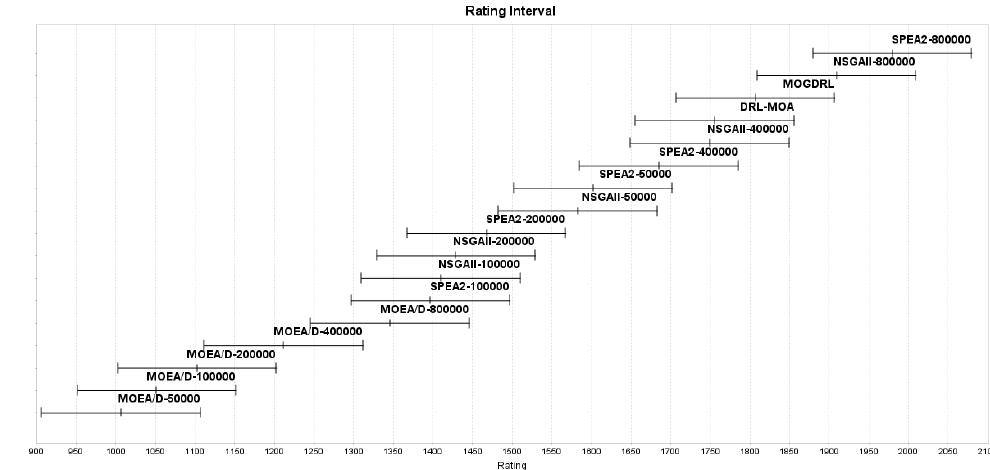
Figure 4. Spread ranking results for 100 cities.